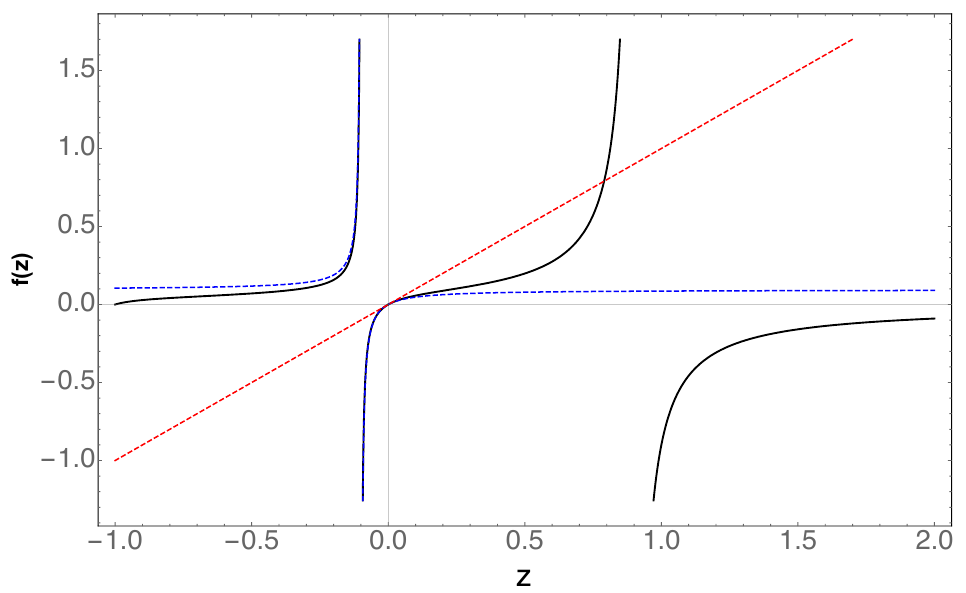
Figure 4 . f ( z ) which resembles the r.h.s. of (B.1). We are interested in a precise approximation of this function close to the origin z = 0. The black solid line is f ( z ) = (cid:0)( z (cid:0) a ) = (cid:0)( z ) = (cid:0)( (cid:0) a ), the blue dashed line f ( z ) = (cid:0) z= ( z (cid:0) a +1) = (cid:0)( (cid:0) a ) (double pole approximation) and the red dashed line f ( z ) = z (single pole approximation). The chosen numerical value is a = 0 :